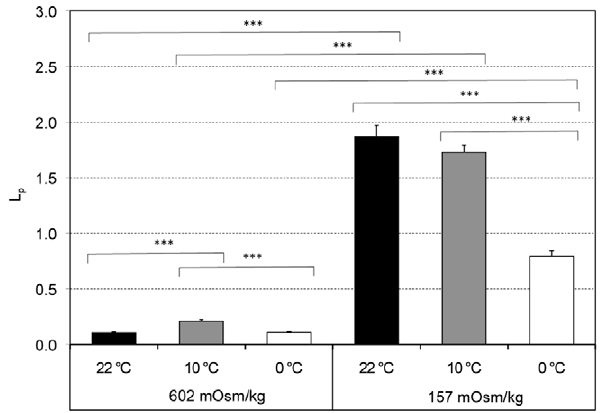
Figure 6. Arrhenius plots for COS-7 cells. The upper line represents the fit for hypotonic conditions (157 mOsm/kg), indicated by circles, and the lower line is the fit for hypertonic conditions (602 mOsm/kg), indicated by triangles, at temperatures of 0 and 10 u C. The activation energy, E a , of the hypotonic L p values was 12.0 kcal/mol. The value for E a of the hypertonic L p values was 10.7 kcal/mol. The L p values gained at 22 u C (open symbols) were not used for the calculation of E a , for reasons given in the discussion.